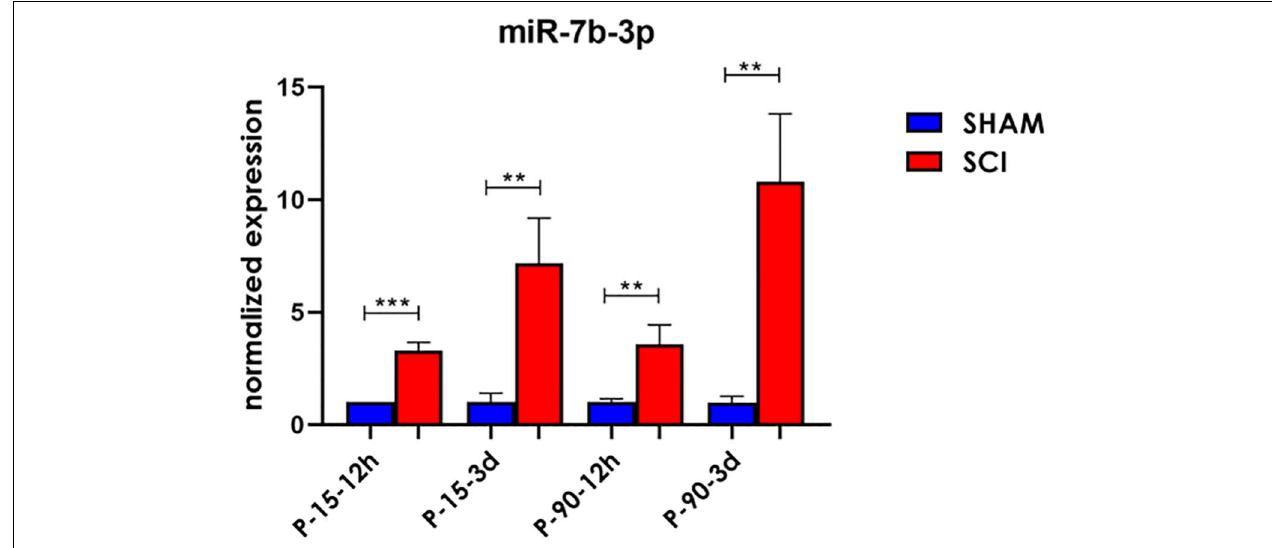
FIGURE 2 | miR-7b-3p upregulation following SCI. miR-7b-3p upregulation in all SCI groups was confirmed by RT-PCR. The graph expresses miRNA normalised relative expression values ± SEM (Mann–Whitney *** p < 0.001; ** p < 0.01; n = 8 for each group).